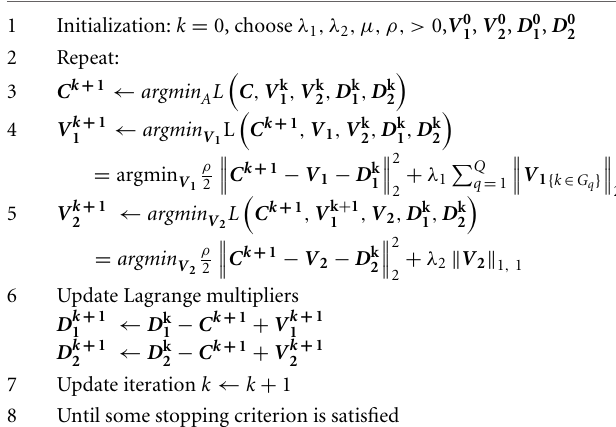
Table 1 | Algorithm of solving multitask-sglasso by